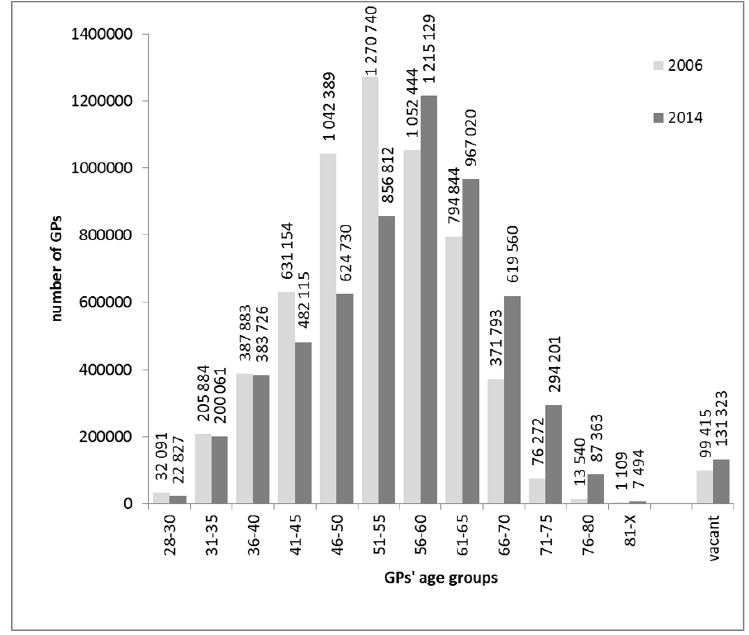
Figure 2. Number of 18–64-year-old adults receiving care from general medical practices by general practitioner (GP) age and in practices with vacant GP post between 2006 and 2014 in Hungary.